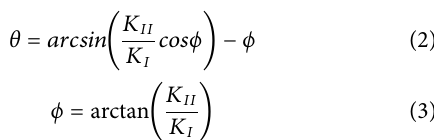
Frontiers in Earth Science |